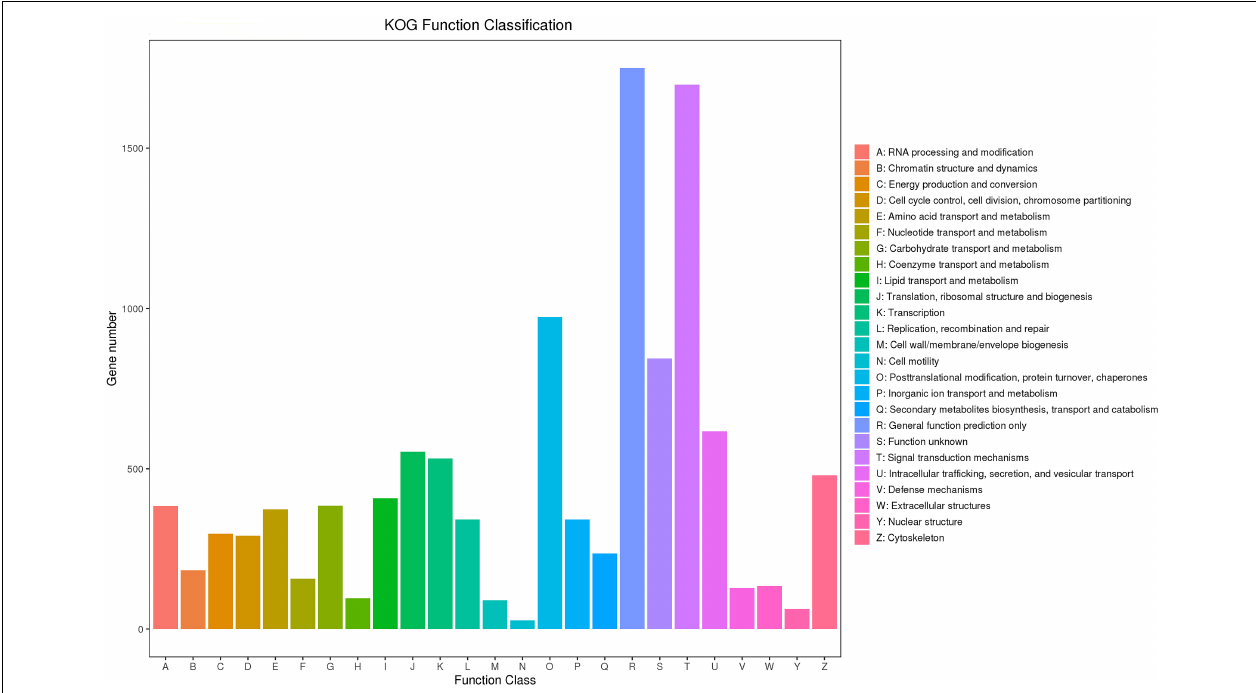
FIGURE 3 | KOG functional classification diagram. The horizontal axis indicates the KOG functional classification, and the vertical axis indicates the number of genes.